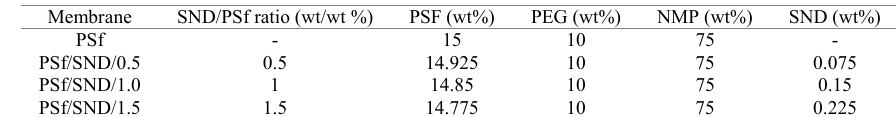
Table 1. Casting solution composition of neat and nanocomposite PSf